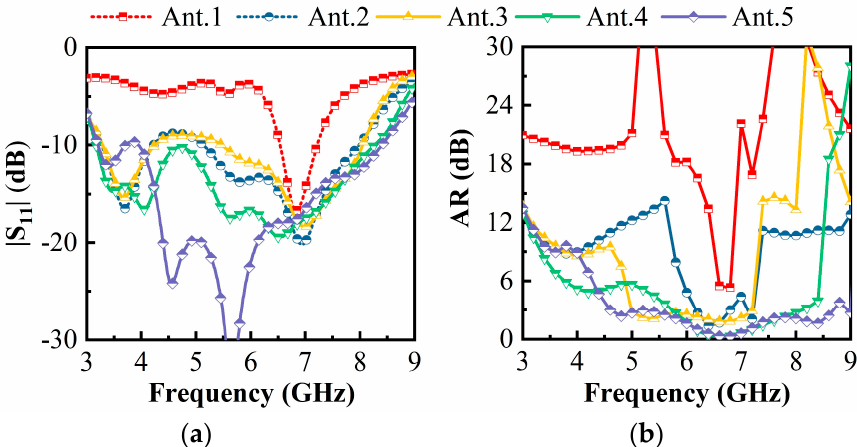
Figure 3. Simulated reflection coefficient ( a ) and AR ( b ) of the reference antenna with different configurations.